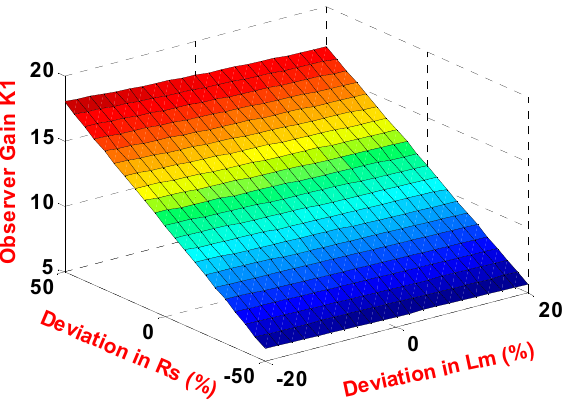
Figure 6. The optimal setting of observer feedback gain K 1 at different deviations in R s and L m using PSO. To extract a formula for gain K 1 as a function of deviation in stator resistance and mutual inductance ( ∆ R s , ∆ L m ), the 3D relationship in Figure 6 was analyzed